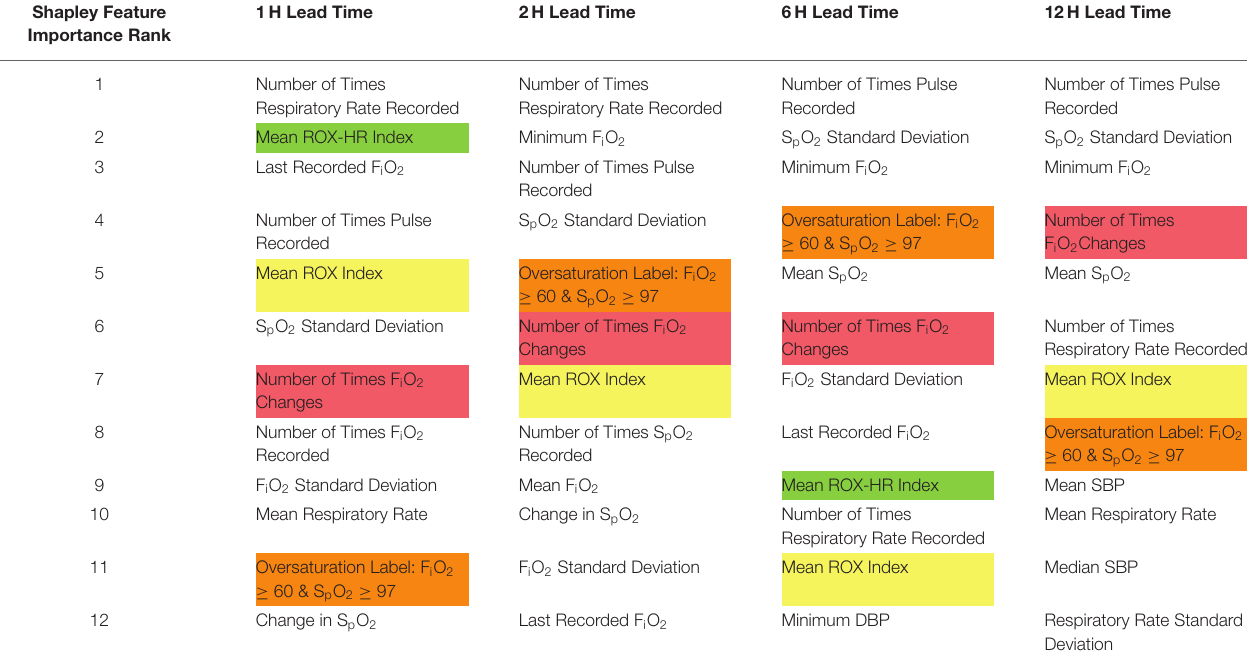
TABLE 2 | Top twelve feature importance rankings based on Shapley values. Shapley Feature Importance